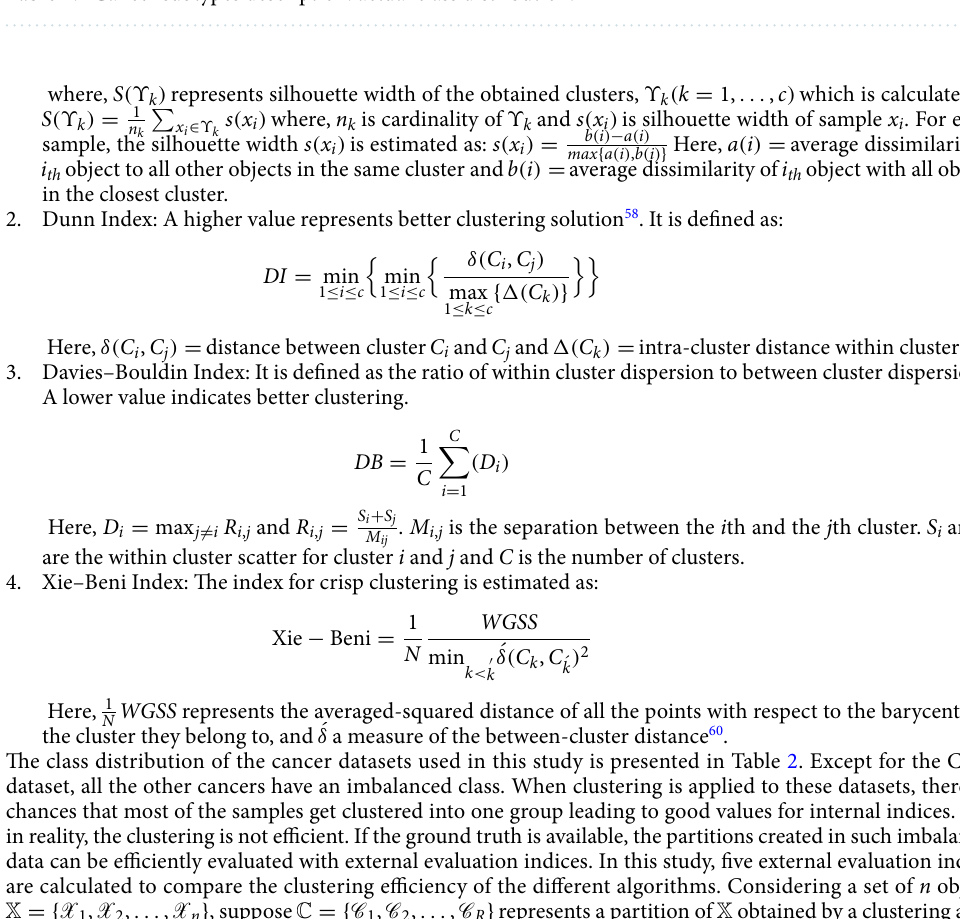
Table 2. Cancer subtypes description: actual class